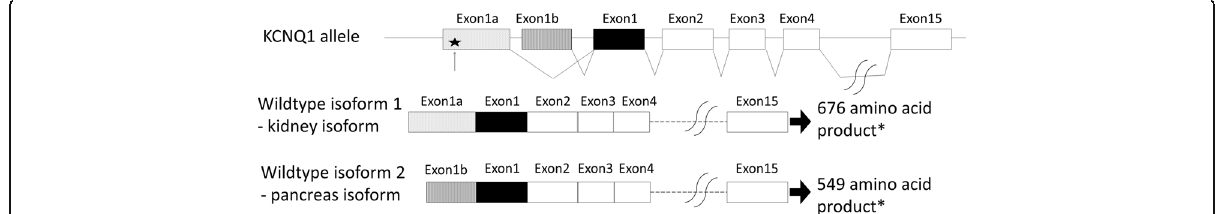
Fig. 1 Exon – intron structure and alternative transcripts of the human KCNQ1 gene. The two wild-type isoform transcripts, the kidney and pancreas isoforms, are composed of exons 1a and 1 – 15 (kidney isoform) encoding 676 amino acids or exons 1b and 1 – 15 (pancreas isoform) encoding 549 amino acids [1, 4]. The arrow and star indicate the nonsense variant (NM_000218.2:c.115G > T, p.Glu39X) in exon 1a of the KCNQ1 gene. *, both isoforms can form a functional cardiac potassium channel [1, 2]